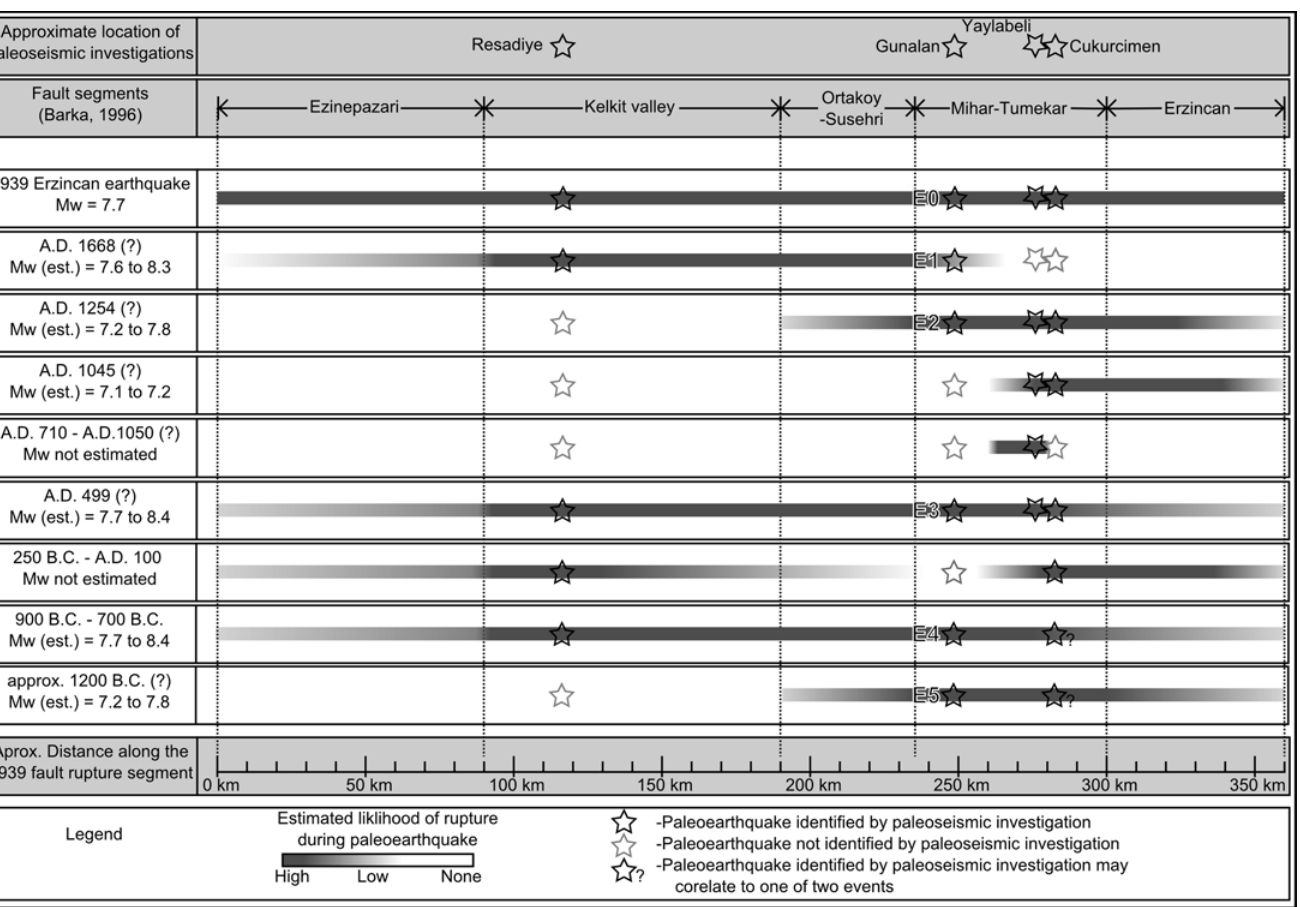
Figure 10. Summary plot of the along-strike paleoearthquake fault rupture segments estimated using the timing of the earthquakes determined in the different paleoseismic investigations along the 1939 Erzincan earthquake fault-rupture segment. Data for each of the sites come from: Resadiye, Fraser [2009b]; Günalan, this study; Yaylabeli, Kozaci et al. [2011]; and Cukurcimen, Hartleb et al.